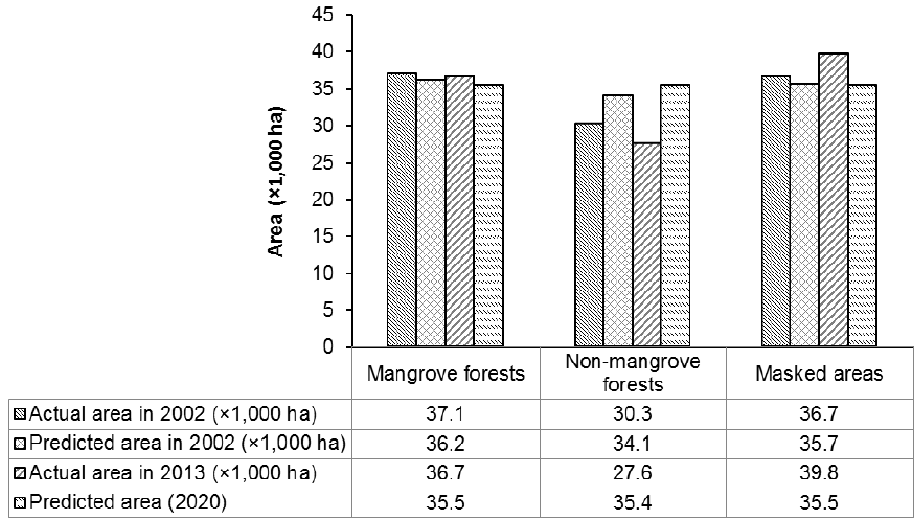
Figure 6. Comparison between land-cover projected results achieved from the transition matrix during 1985–2013 and the classification results for 2002 and